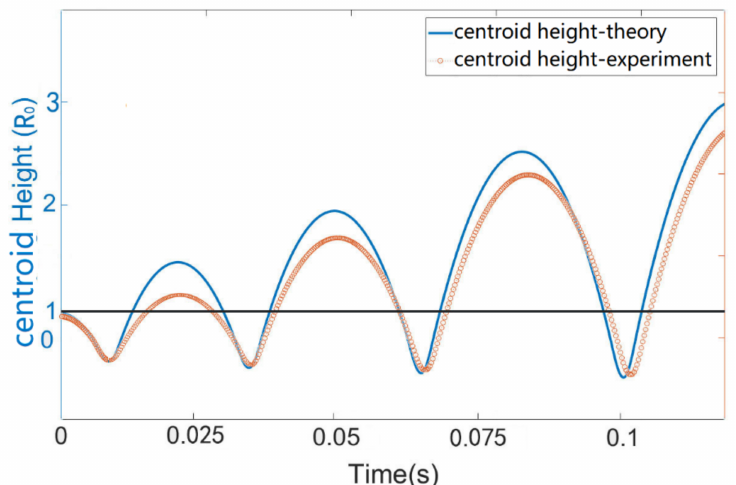
Figure 6. Centroid height ( H CM , Y axis) as a function of time for the droplet trampolining on a superhydrophobic surface, driven by electrowetting force applied during the spreading phase of each impact cycle; the applied AC signal is a 200 V sine wave of 10 KHz. Red dotted line represents the experimental results, and the blue solid line represents the theoretical values according to the driven droplet spring model as discussed in Section 3.3. The dark line represents the equilibrium radius ( R 0 ∼ 0.62 mm) of the 1 uL droplet. The dots above and below the dark line indicate the flying and impacting phases, respectively, and the time from impacting ( H CM = 0) to recoiling ( H (cid:48) marks the duration of the